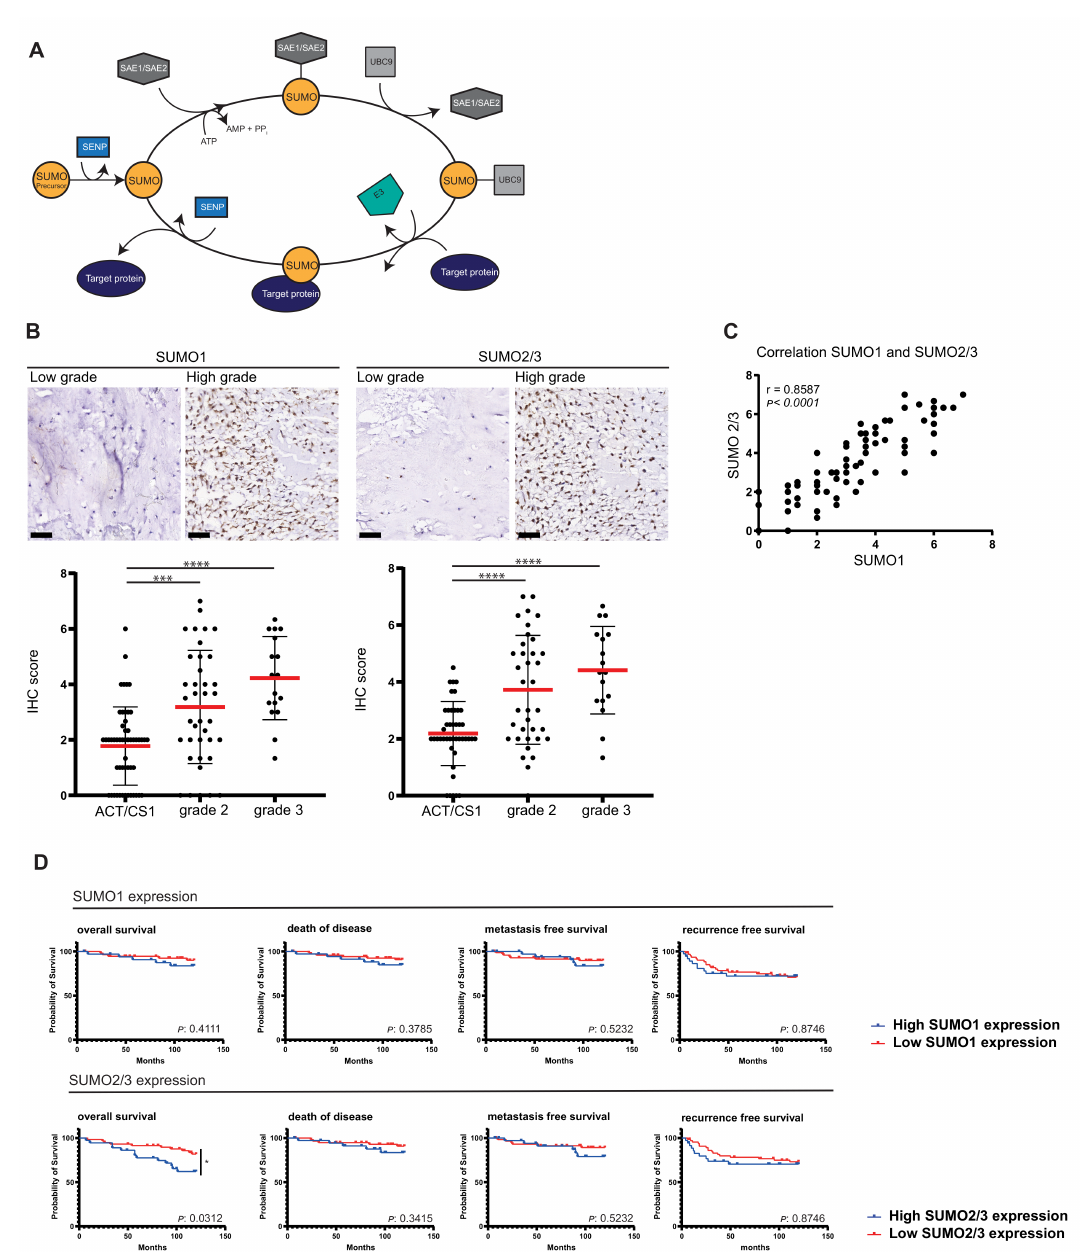
Figure 1. SUMO expression levels correlate with increasing histological grade of chondrosarcoma tumors and, thus, tumor aggressiveness, and poorer disease outcome. ( A ) Cartoon of the SUMOylation cycle. The SUMO precursor proteins are cleaved by SENPs to produce mature SUMO proteins. Subsequent SUMOylation of a target occurs via an enzymatic cascade involving an E1 (activating), E2 (conjugating), and E3 (ligase) enzyme. ( B ) Expression levels of SUMO1 and SUMO2/3 in chondrosarcoma primary tumors; atypical cartilage tumor/chondrosarcoma grade 1 (ACT/CS1) and grade 2 and grade 3 (high grade). Scale bars represent 50 µ m. Dot-plots represent IHC scoring for SUMO1 and SUMO2/3 on tissue microarrays presented as mean with standard deviation. ***: p < 0.001, ****: p < 0.0001. Each dot represents the average of three cores per tumor. p values were calculated using one-way ANOVA followed by Tukey’s multiple comparison. ( C ) The correlation between SUMO1 and SUMO2/3 levels is shown for every tumor sample separately. Correlation calculation of SUMO1 vs. SUMO2/3 results in an R of 0.8584 and p < 0.0001. ( D ) Survival curves showing overall survival, death of disease, metastasis free survival and recurrence free survival, displaying high expression of SUMO1 or SUMO2/3 versus low expression of SUMO1 or SUMO2/3. SUMO expression was determined based on the scores of the TMAs from ( B ). Log-rank (Wilson–Cox) analysis was used to calculate significance. *: p < 0.05 Cox regression analysis for the survival data shown in ( D ) is depicted in Table